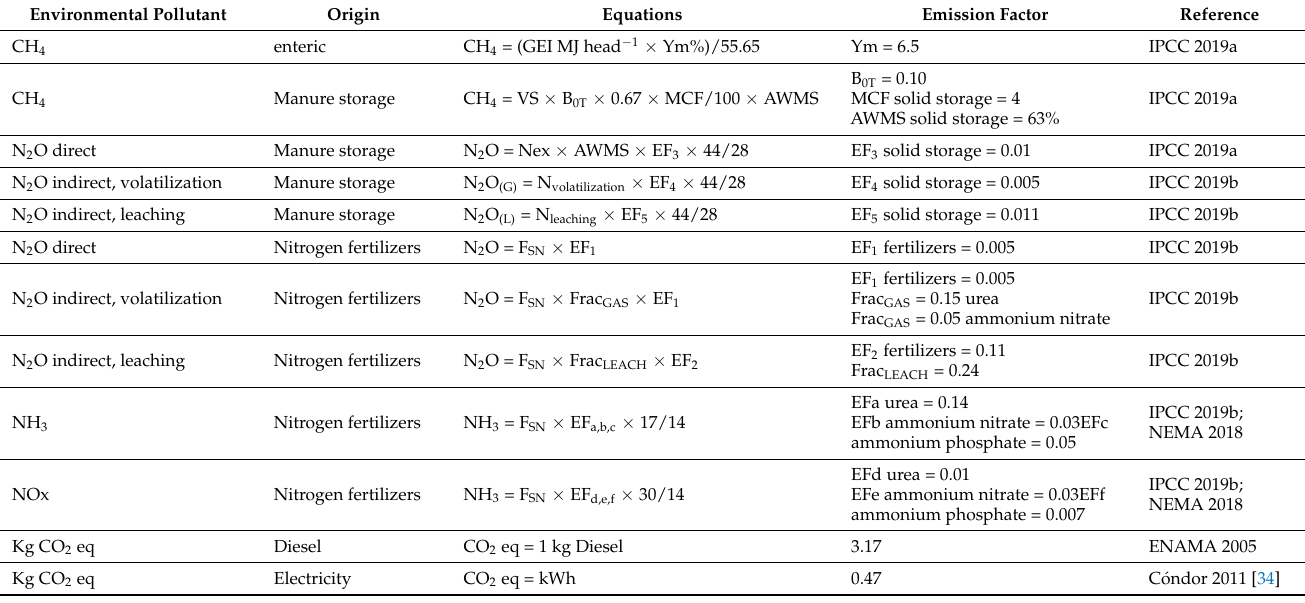
Table 5. Emissions factors and equations